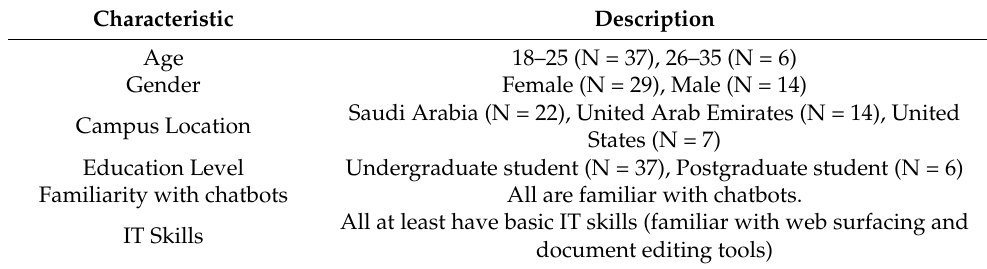
Table 2. Participants’ demographical